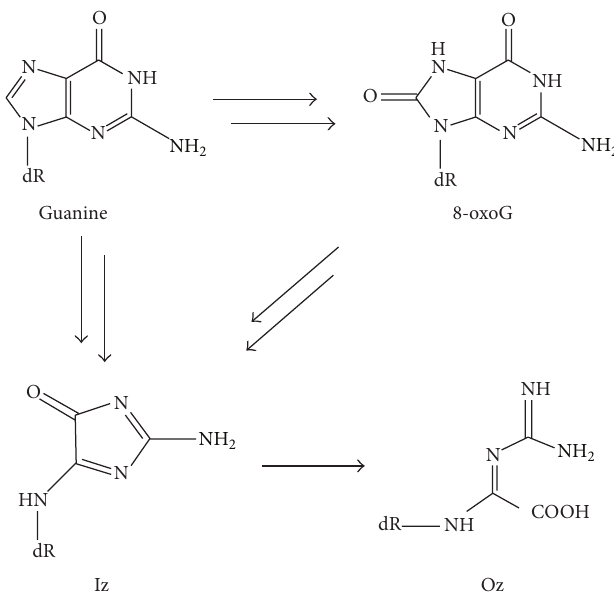
Scheme 1: Products of oxidation of guanine and 8-oxoG.